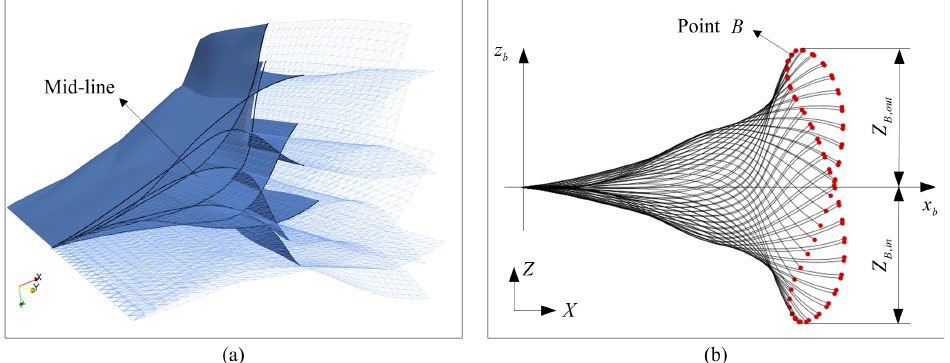
Figure 3. Envelop of an isolated flapping flexible plate: ( a ) 3D envelop of the flapping plate; ( b ) envelop of the plate’s